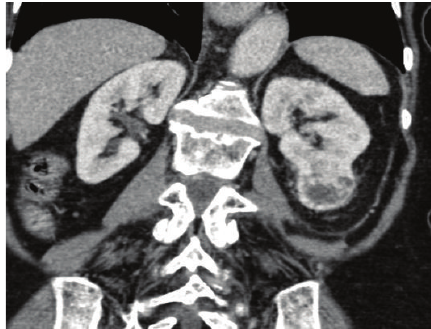
Figure 5: CT urogram (coronal urographic phase image) demon- strates a large polypoid mass arising from the bladder wall. This was confirmed to be a urothelial cell carcinoma following biopsy at cystoscopy.